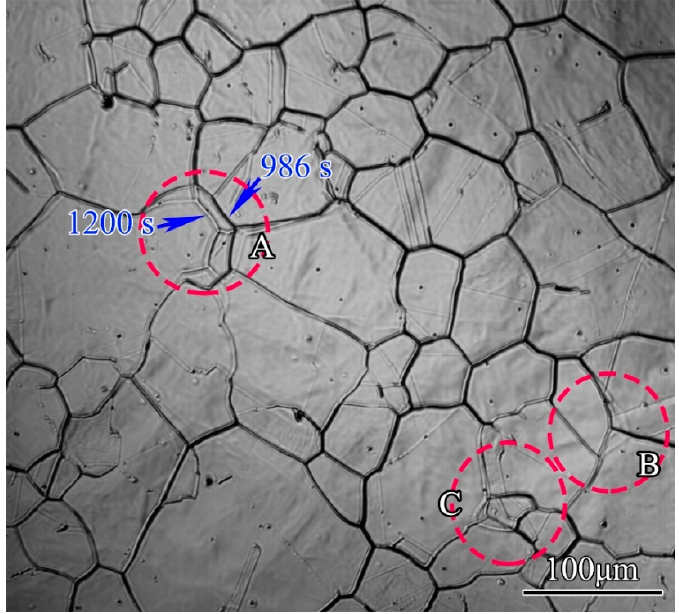
Figure 11. Grain boundary migration at 1200 °C.